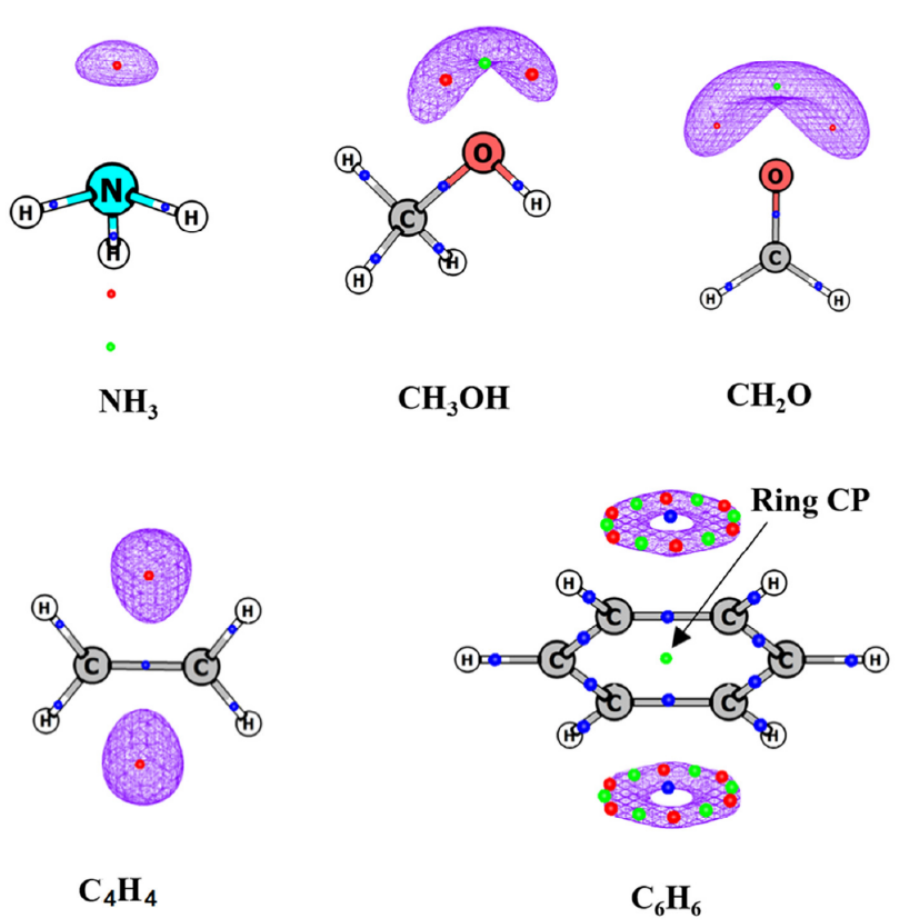
Figure 2. MESP topology of some molecules obtained from B3LYP/6-311G(d, p) calculations. Blue, green and red dots correspond to (3, − 1), (3, +1) and (3, +3) critical points (CPs). Isosurface values are − 60, − 40, − 30, − 15, and − 10 kcal/mol for NH 3 , CH 3 OH, CH 2 O, C 2 H 4 , and C 6 H 6 , respectively. MESP can attain negative values in contrast to MED, which is strictly